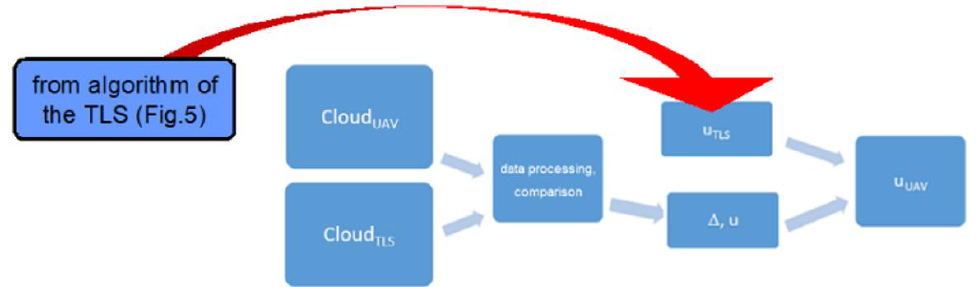
Figure 7. Algorithm of the UAV method accuracy estimation, where: Cloud UAV , Cloud TLS —clouds of points related to the methods UAV and TLS, respectively, ∆ , u —absolute values of occurred errors and related uncertainties, u TLS , u UAV —measurements uncertainties characterizing the methods TLS and UAV, respectively.